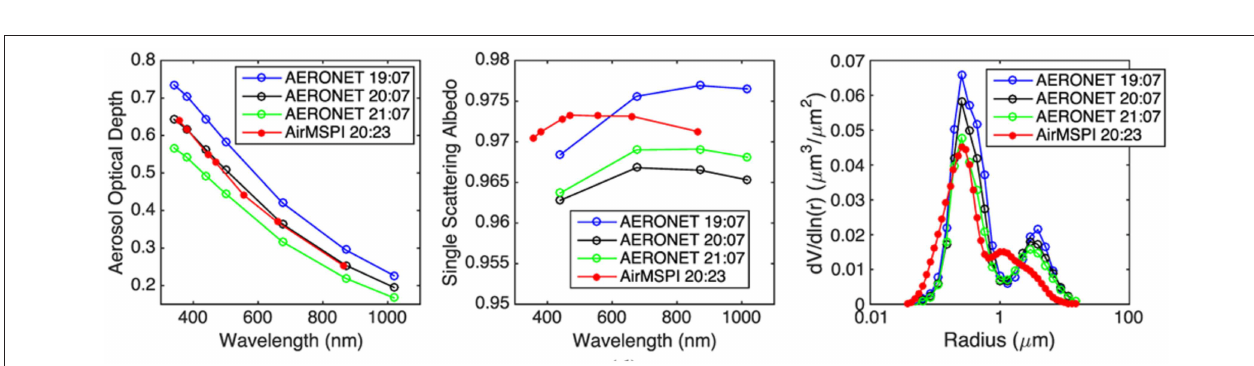
FIGURE 7 | AirMSPI-retrieved aerosol optical depth (AOD), single scattering albedo (SSA), and volume-weighted aerosol size distribution collocated with the Fresno AERONET site on January 6, 2012, compared to the AERONET-derived values. Different times of observation noted. Adapted with permission from Xu F. et al. (2017), John Wiley &